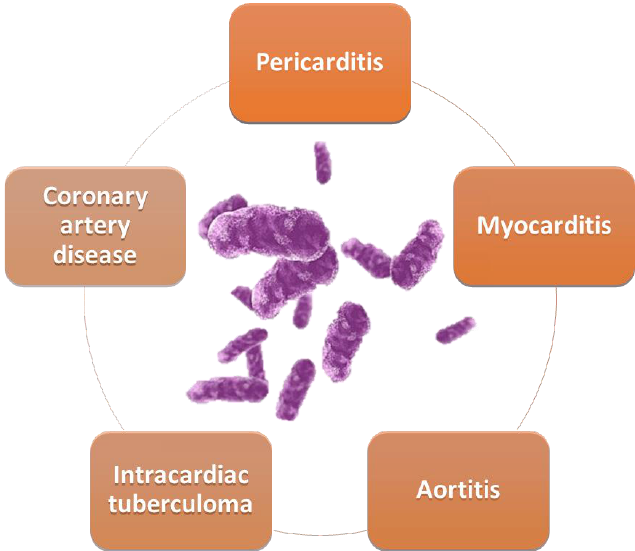
Figure 1. Cardiovascular involvement in TB.